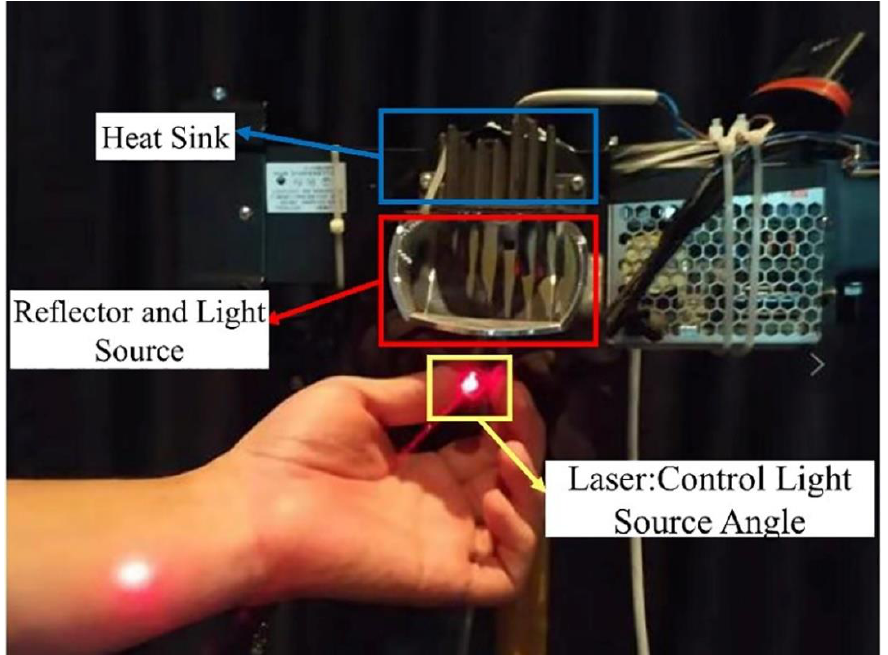
Figure 4. High-beam headlight binding.